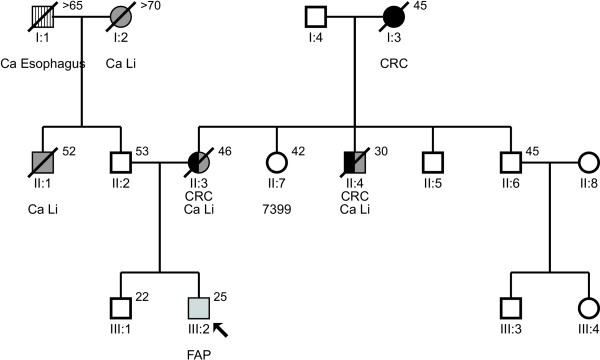
Family tree of the FAP family carrying a gross APC deletion. Though no sample is available for individuals I:3, II:3 and II:4, phenotype, cause and age of death indicate the presence and direct transmission of the deletion identified in the proband (III:2). (CRC: Colorectal Cancer, Ca Li: Liver cancer).